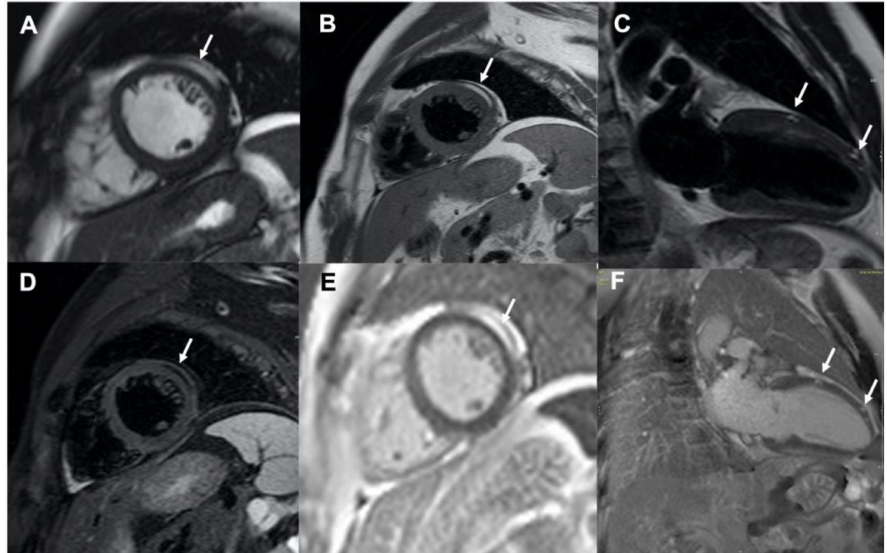
Figure 1. Cardiac magnetic resonance imaging showing multiple areas of intramyocardial fat deposition (white arrows); ( panel A ): b-steady-state free precession cine sequence, mid short-axis view; ( panels B,C ): T1-weighted black-blood Turbo Spin Echo images, mid short-axis view and 2-chamber view, respectively; ( panel D ): T1-weighted black-blood Turbo Spin Echo image with fat suppression, mid short-axis view; ( panelsE,F ):lategadoliniumenhancementimages,